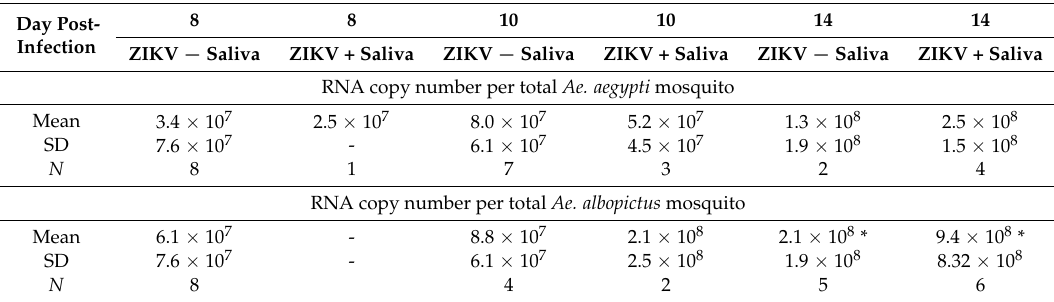
Table 2. Viral RNA levels detected in Ae. aegypti and Ae. albopictus mosquitoes according to the presence/absence of ZIKV in their